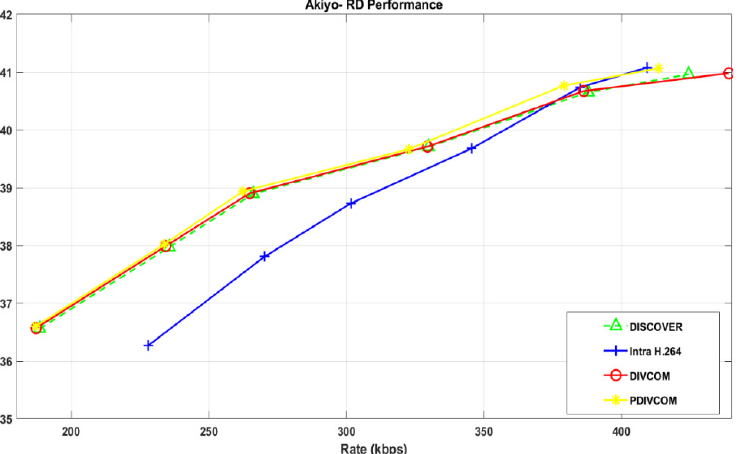
Figure 3. Rate-distortion (RD) performance graphical evaluation of “Akiyo” test video sequence with frame rate of 15 Hz and GOP 2.